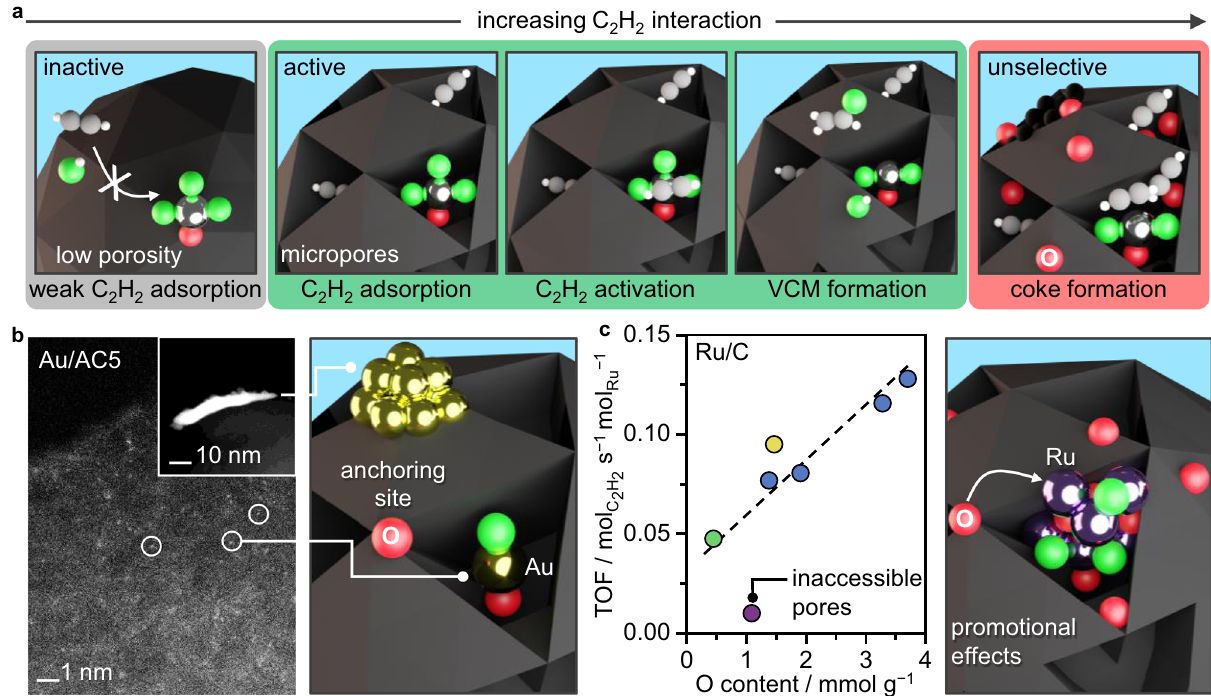
Fig. 5 Metal-dependent role of the support. a Mechanistic scheme of acetylene hydrochlorination exempli fi ed over Pt/C catalysts as a function of increasing acetylene adsorption capacity, regulated by the porosity and oxygen content of the carbon support (gray: too weak, green: optimal, red: too strong). b , c Additional roles of the oxygen functionalities in determining the metal nanostructure of Au/C, exempli fi ed by the STEM of fresh Au/AC5, and the initial activity of Ru/C